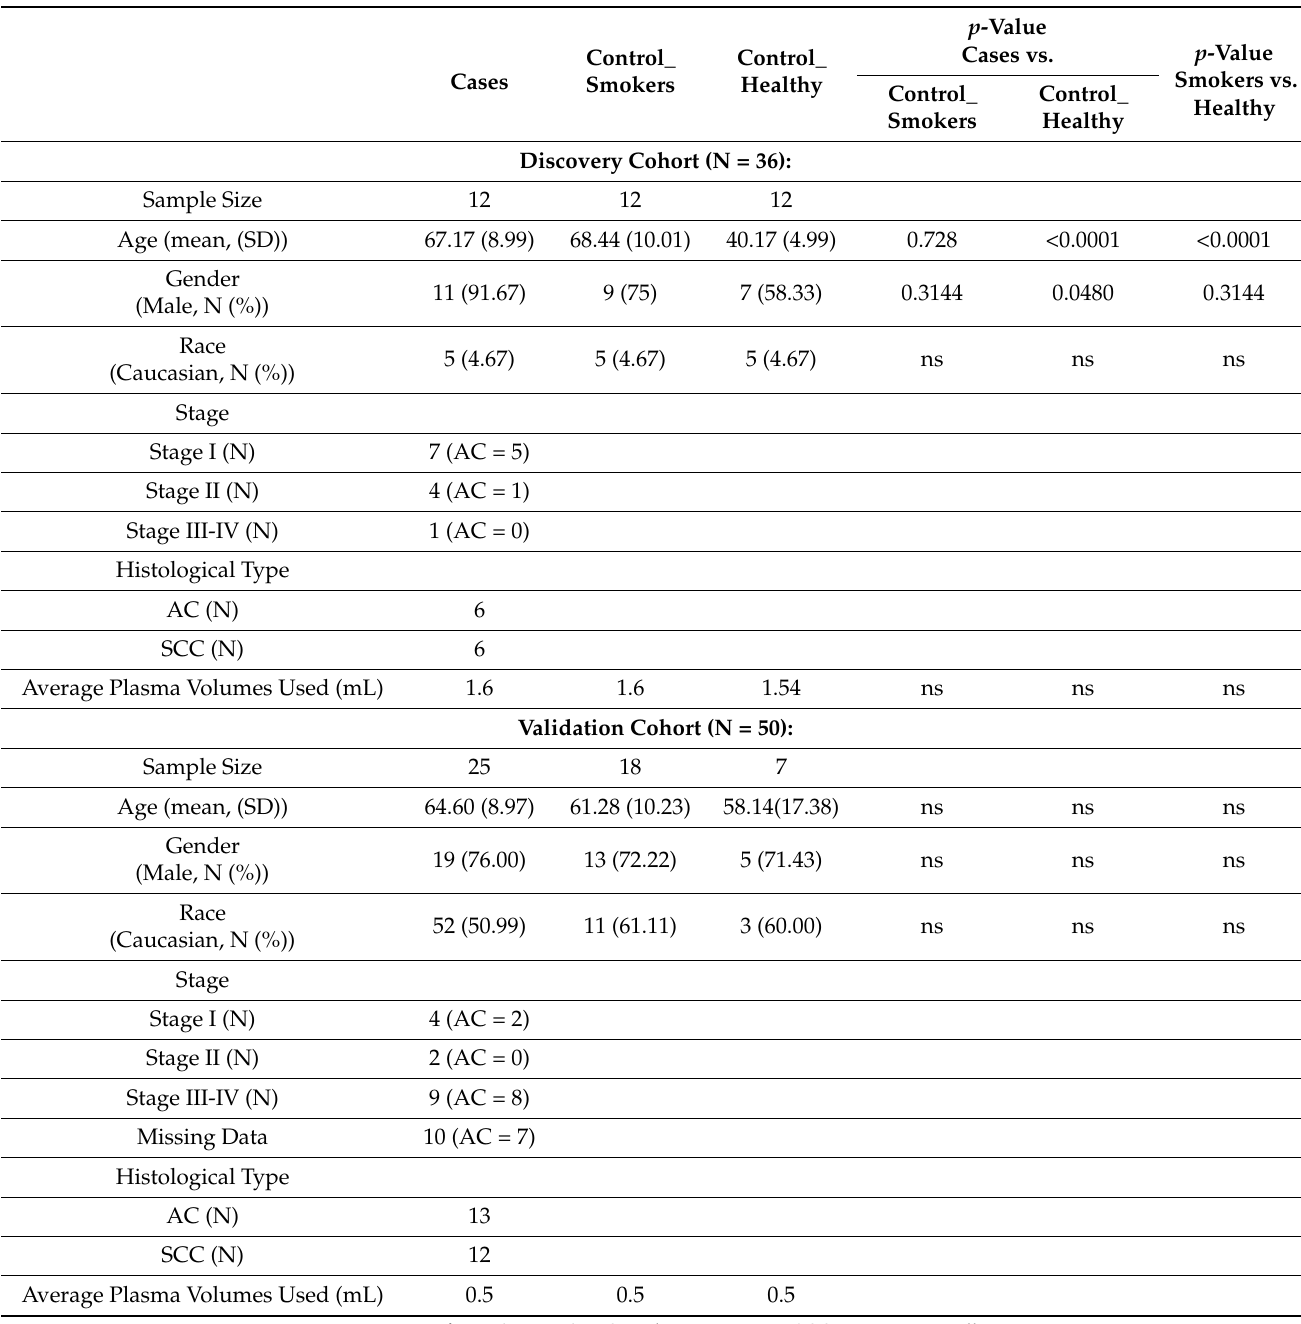
Table 1. Demographic and clinical